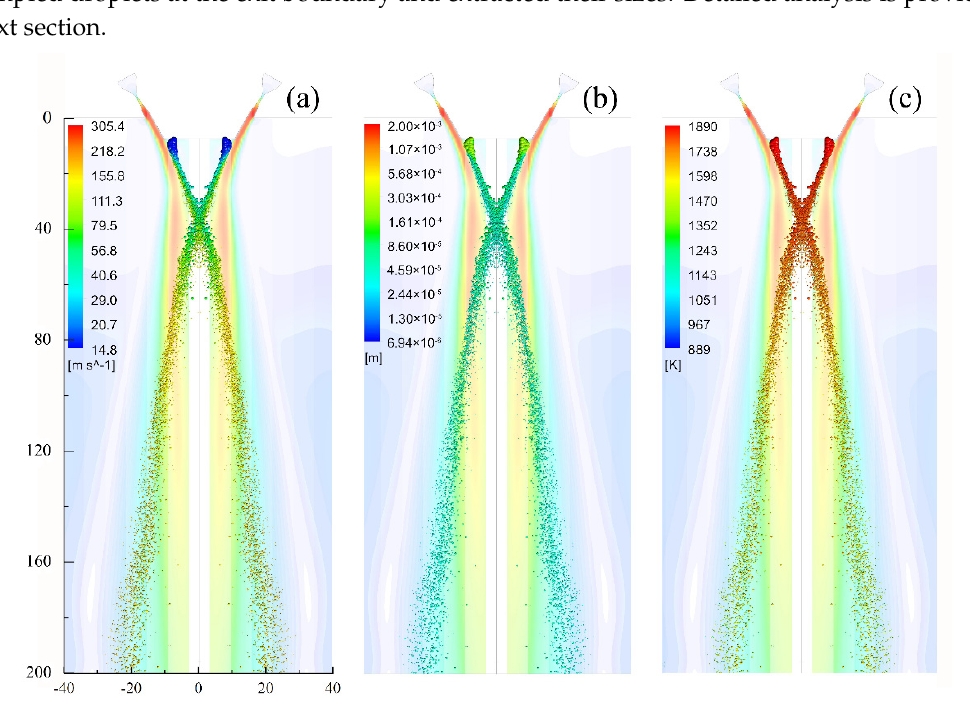
Figure 9. The particle trajectories for the particle velocity magnitude; ( a ) particle velocity, ( b ) particle diameter, and ( c ) particle temperature for the KHRT breakup models.